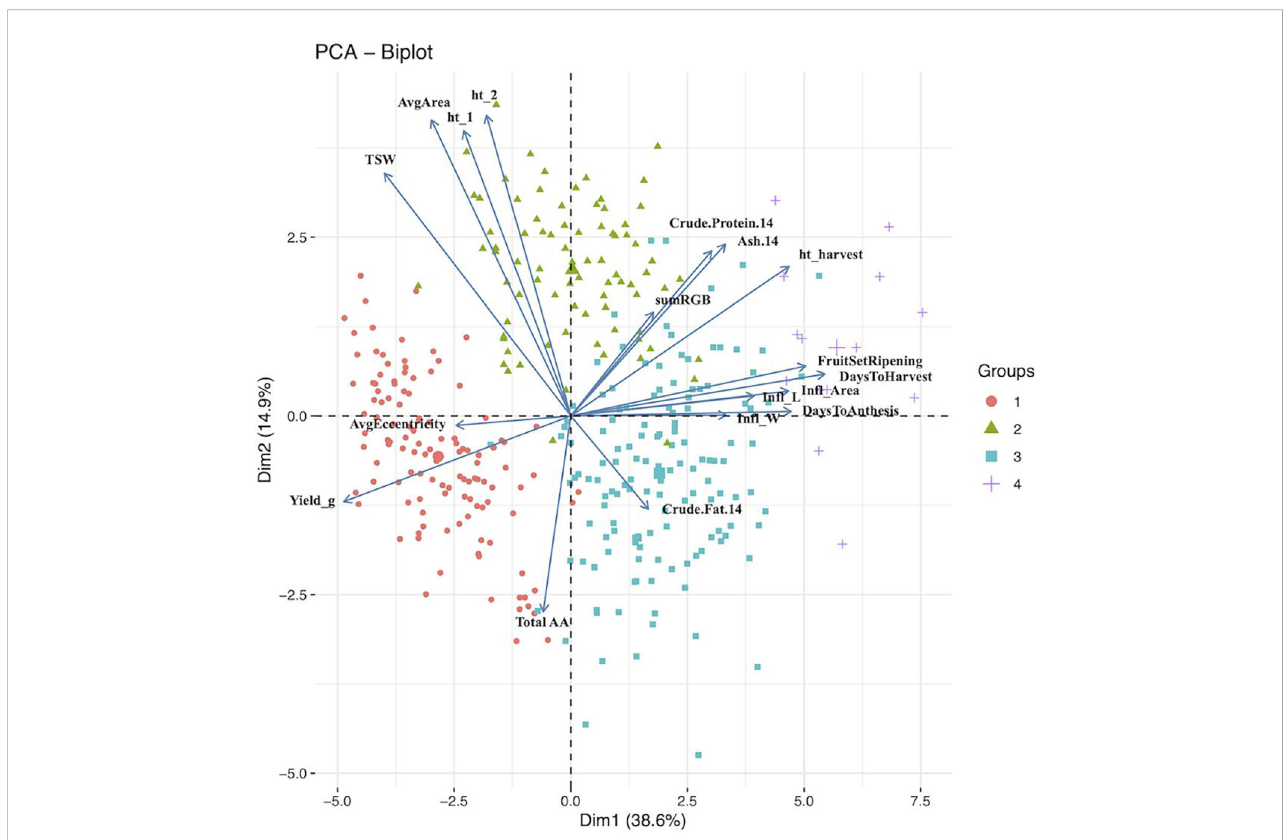
FIGURE 1 Principal component analysis biplot for dimensions 1 (Dim1) and 2 (Dim2). The groups (n =4) are color and shape coded according to agglomerative cluster analysis using Ward ’ s method. The larger shape for each group represent the group centroid. 14, 14% moisture; In fl , in fl orescence; ht_1, height 5 weeks after sowing; ht_2, height 6 weeks after sowing; TSW, thousand seed weight; Avg, average; AA, amino